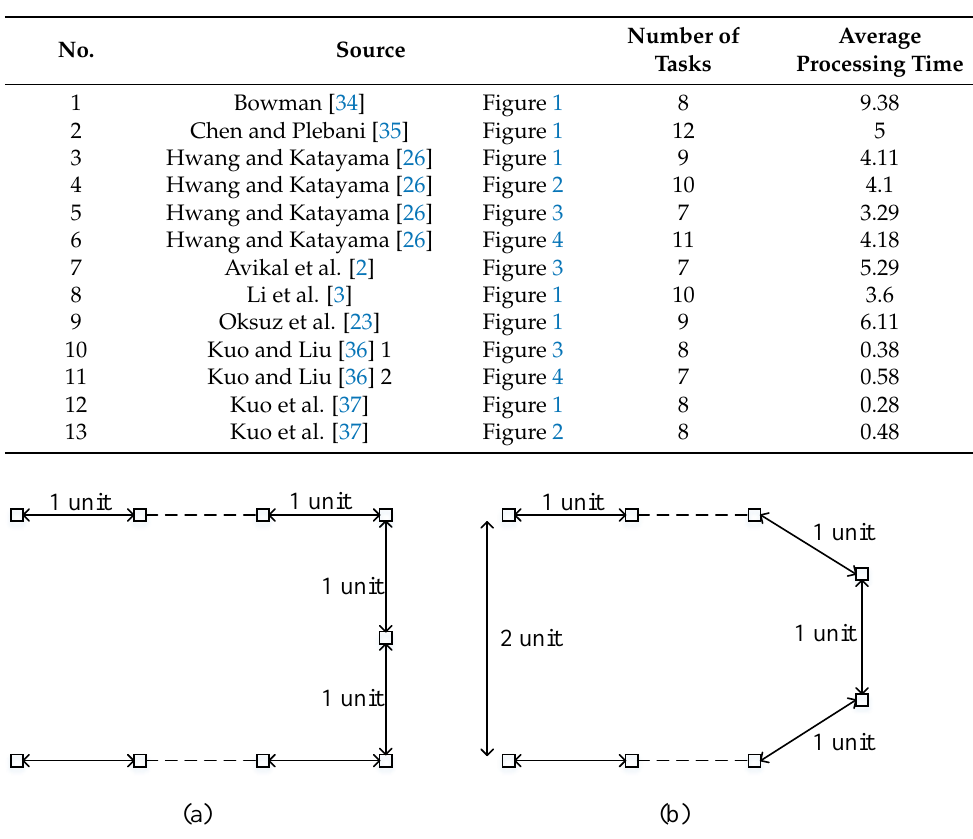
Table 2. Summary of experimental problems.